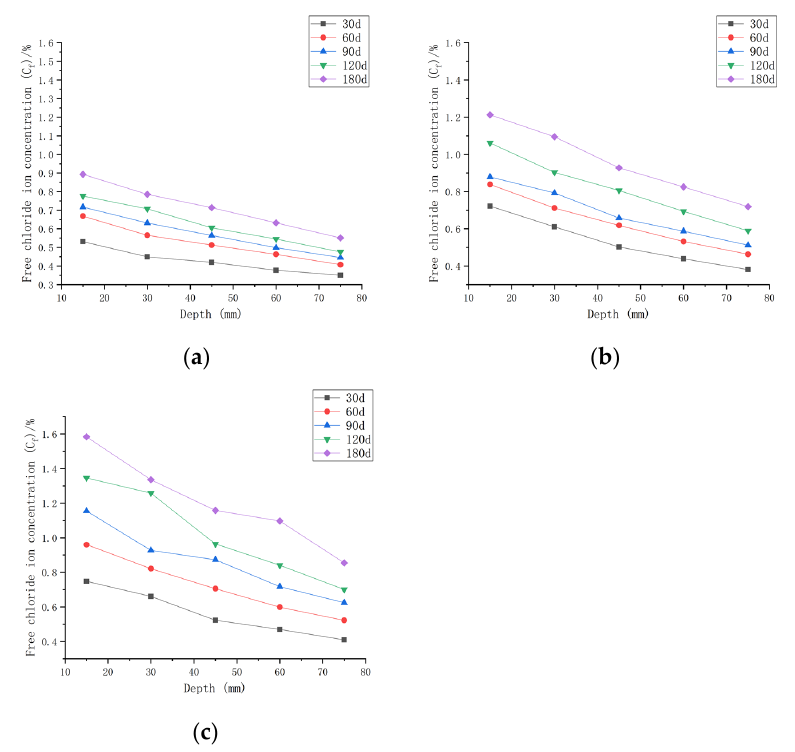
Figure 7. Relationship between free chloride ion concentration and depth of CASC with water–cement ratio 0.30 at different test times and loads. ( a ) Load is 0; ( b ) load is 0.1. After 30 days of seawater erosion, the largest rise in C f , from 65.08% to 132.49%, was noticed when the water–cement ratio was 0.30 and the load was changed from 0 to 0.2. From 60 days to 120 days of seawater erosion, the maximum increase in C f was from 23.09% to 34.85%. The maximum increase in C f was from 17.81% to 30.56% after 180 days of seawater erosion. As shown in Figure 8, when the water–cement ratio was 0.35 and the load was 0, the C f increased by 2.62%~35.68% after 30 days of seawater erosion compared with the initial chloride ion concentration at the water–cement ratio of 0.35 ( C 0 , 0.35). After seawater ero- sion from 60 days to 120 days, the C f increased by 8.04%~ 23.86% compared to the C f of 30 days earlier. After 180 days of seawater erosion, C f increased by 17.85%~29.18% compared to the C f at 120 days. When the water–cement ratio was 0.35 and the load was 0.1, C f in- creased by 9.68%~70.43% after 30 days of seawater erosion compared with C 0 , 0.35. After seawater erosion from 60 days to 120 days, C f increased by 5.72%~31.03% compared with 30 days earlier. After 180 days of seawater erosion, C f increased by 17.29%~ 25.30% com- pared with the C f at 120 days. When the water–cement ratio was 0.35 and the load was 0.2, the C f increased by 20.65%~108.25% compared with C 0 , 0.35 after 30 days of seawater ero- sion. After seawater erosion from 60 days to 120 days, C f increased by 10.51%~22.53% compared to the C f of 30 days earlier. After 180 days of seawater erosion, the C f increased by 10.51%~22.53% compared with the C f at 120 days. When the water–cement ratio was 0.35 and the load was changed from 0 to 0.2, the maximum increment of C f increased from 35.68% to 108.25% after 30 days of seawater erosion. From 60 days to 120 days of seawater erosion, the maximum increase in C f was from 22.92%~31.03%. The maximum increase in C f was from 22.53%~ 29.18% after 180 days of seawater erosion. ( a )